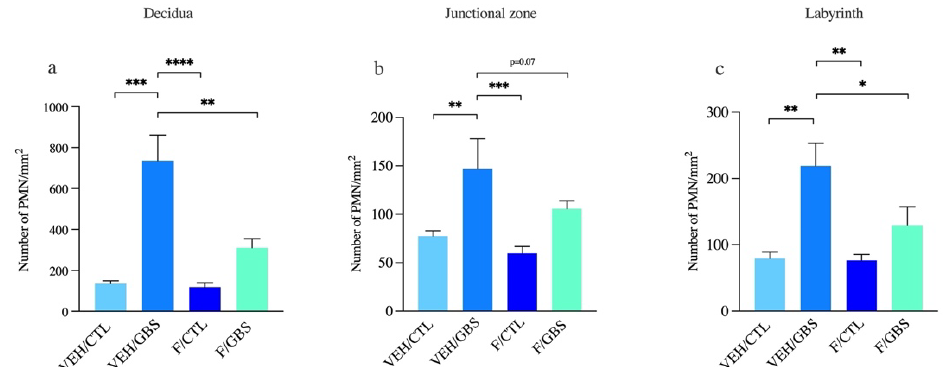
Figure 5. Mean density of PMNs detected in GBS-infected placental compartments. ( a ) decidua (DC) ( b ) junctional zone (JZ), and ( c ) fetal labyrinth (LB). Statistical analyses were done by one-way ANOVA with Dunnett’s multiple comparison (to vehicle/GBS). Bars represent mean ± SEM. Number ( n ) of pups in vehicle/control: n = 4–5, vehicle/GBS: n = 3–6, flutamide/control: n = 5–6, flutamide/GBS: n = 6. One male was used per litter for analysis. * p < 0.05, ** p < 0.01, *** p < 0.001, **** p < 0.0001.